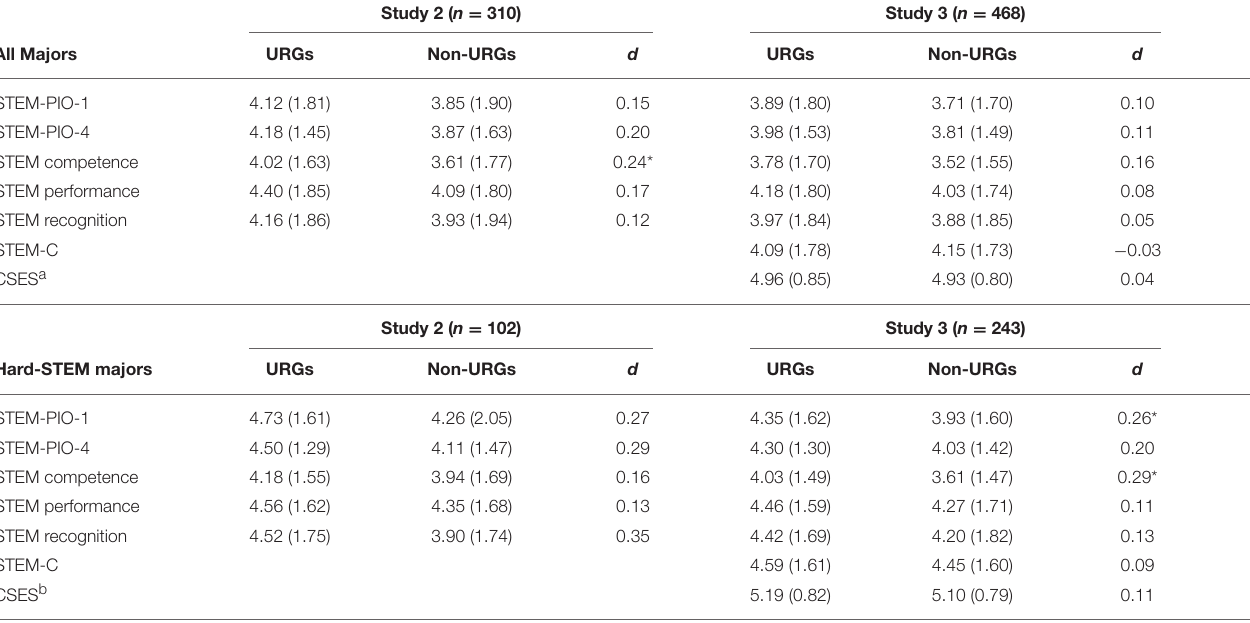
TABLE 6 | Differences in STEM identity by URG